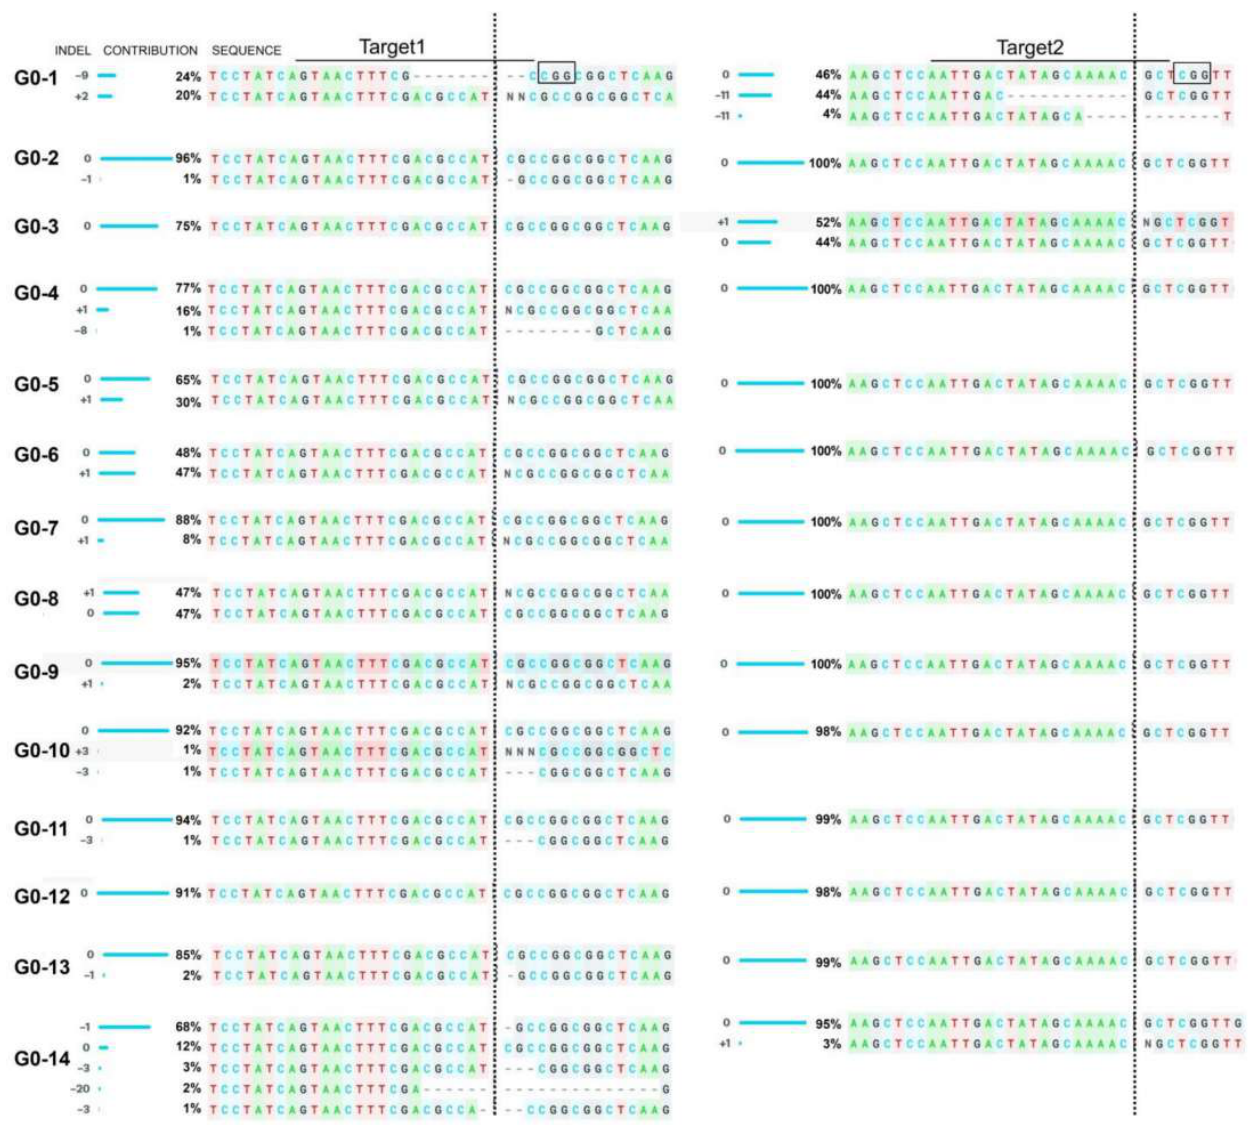
Figure 4. ICE analysis with amplified PCR fragments from slsrfr1 G0 plants. PCR fragments were amplified using genomic DNA isolated from slsrfr1 G0 plants, and the sequences were analyzed by ICE analysis with Sanger sequencing results. The ICE analysis represents the indel pattern in each target sequence of guide RNA, the contribution of each edited pattern, and the genome-edited sequences. Black box indicates the PAM site and the target sequences of guide RNAs are overlined. The ICE contribution values may not add up to 100% based on Sanger sequencing data of a specific sample, because the remaining percent of the decomposed data does not fit in predicted outcomes by ICE program. Vertical stippled lines represent cleavage site by SpCas9 for each sgRNA target. The analyzed sequences are shown in 3’-to-5’ direction through ICE analysis with Sanger sequencing